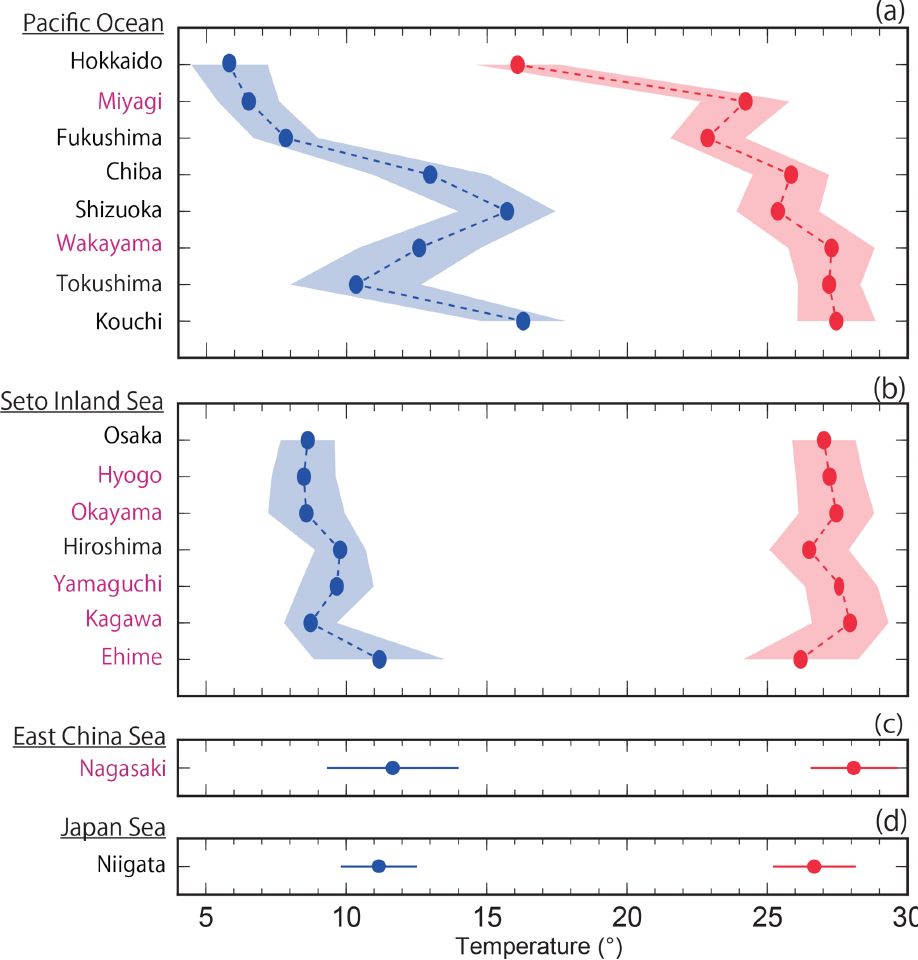
Figure 12. Average highest and lowest temperatures observed for the minimum and maximum pH insitu data for each prefecture. The blue and red lines and shading indicate the average and one standard deviation from the average, respectively. The prefectures that met the threshold of 17 are shown in purple, as in Figs. 9c–l and 11c–l.